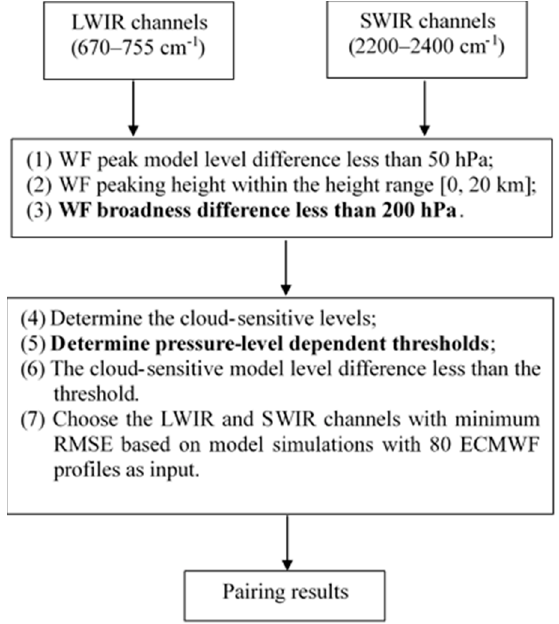
Figure 5. Flow chart summarizing three major steps in the HIRAS LWIR/SWIR pairing procedure. Modifications added in this study to original method are indicated in bold.